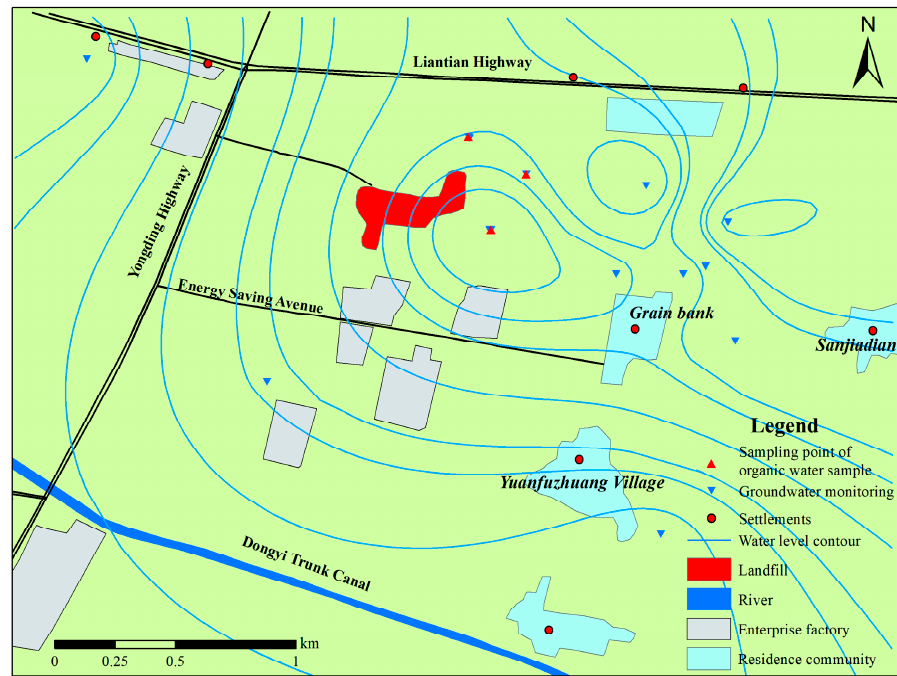
Figure 2. Location map of groundwater monitoring sites in the study area.